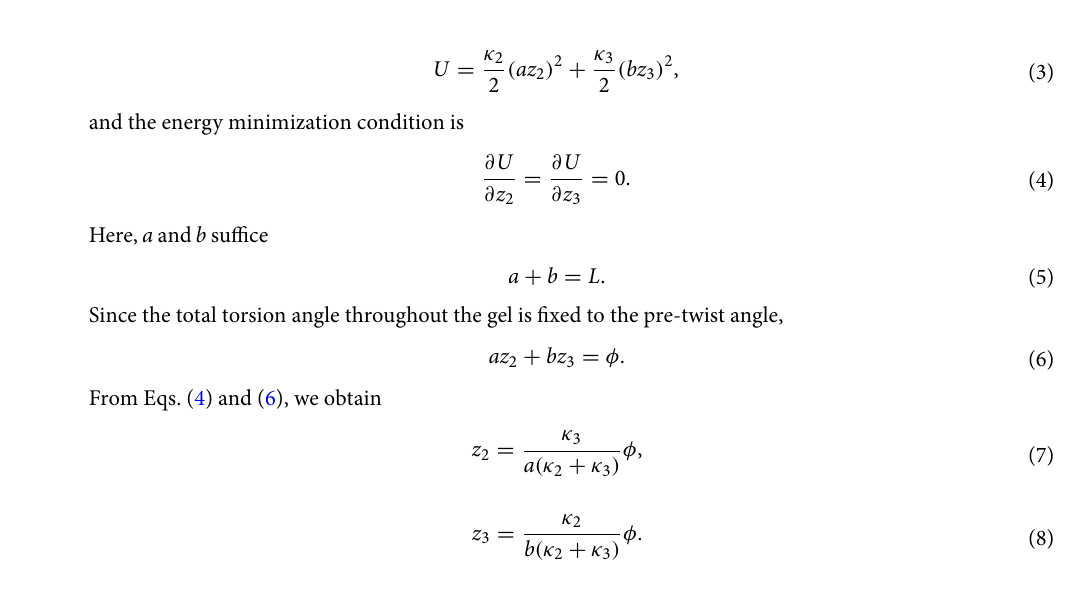
Figure 2. Propagation of chemical waves typically observed in a cylinder-shaped BZ gel. Time is indicated by the number on the left. In this case, the degree of swelling ([diameter in swelling state]/[diameter in contracting state]) ≈ 1.05 , the oscillation period ≈ 301 s, and the wavelength ≈ 12